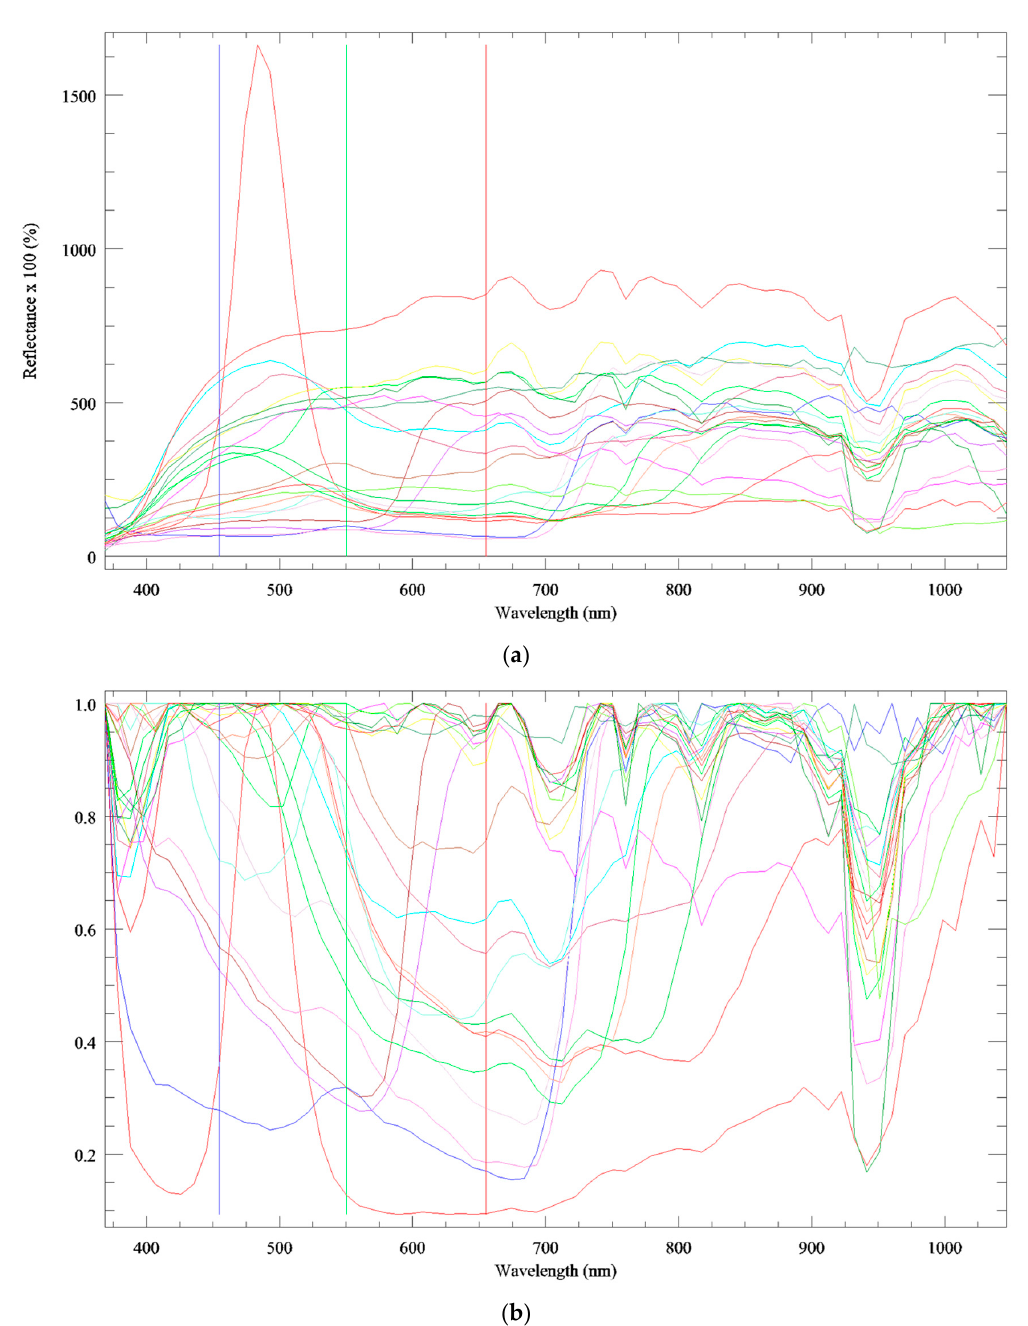
Figure 9. The spectra of ( a ) reflectance, and ( b ) normalized reflectance for the 21 endmembers retrieved from the MNF-inversed full strip image.